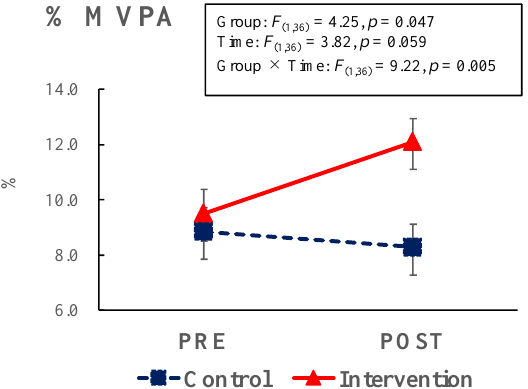
Figure 1. Changes in physical activity and sedentary behavior between intervention and control classes.